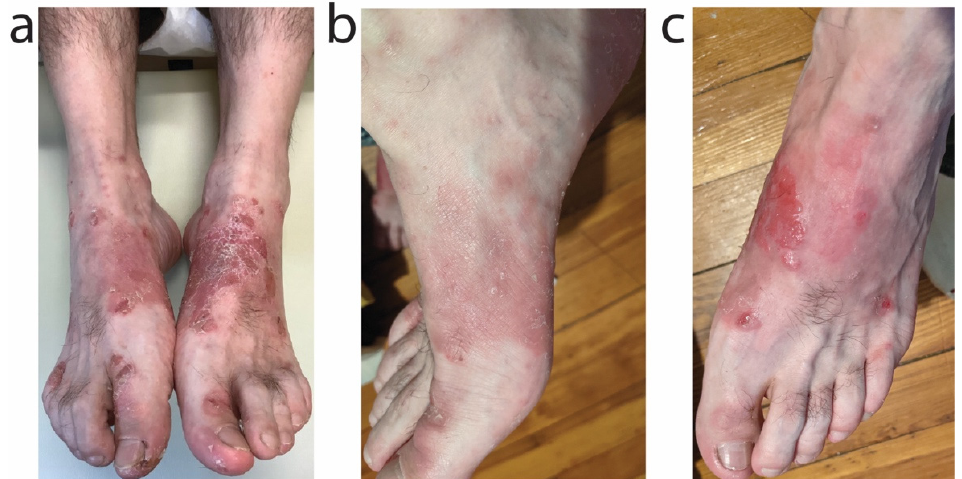
Figure 5. Impetiginized, dyshidrotic atopic dermatitis of the feet improved with oral sarecycline. ( a ) Dyshidrotic atopic dermatitis of the bilateral feet with heavy growth of methicillin-sensitive S. aureus on culture. The impetiginized atopic dermatitis of the right ( b ) and left ( c ) feet improved after 9 days of oral sarecycline 100 mg daily.